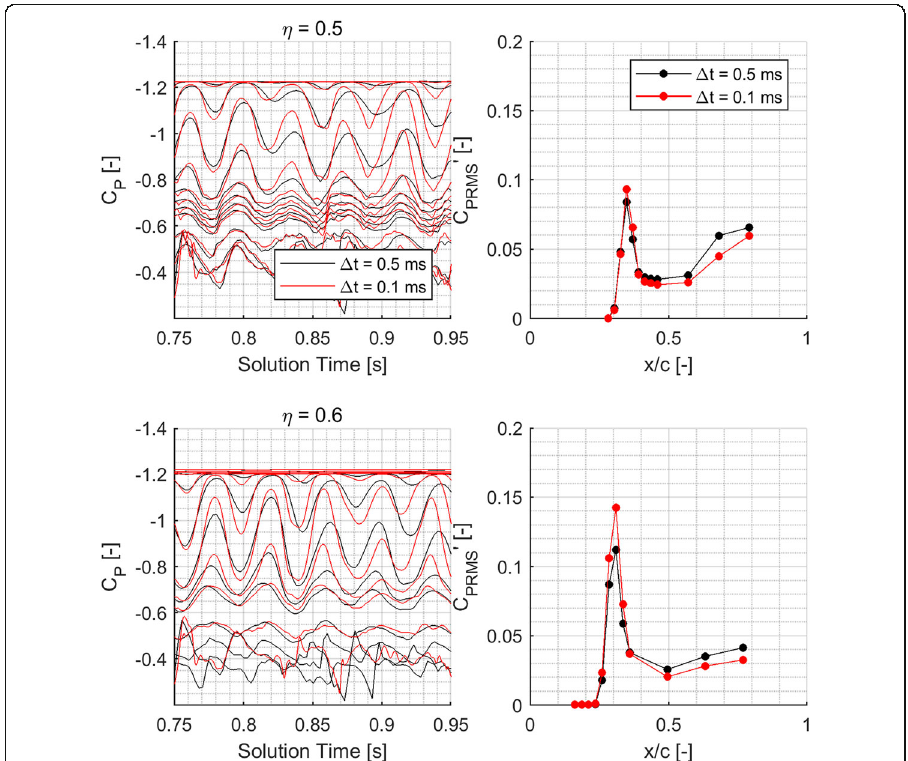
Fig. 4 Time step sensitivity analysis in the unsteady surface C P at η = 0.5 & 0.6. Each signal in the left hand side corresponds to an x/c